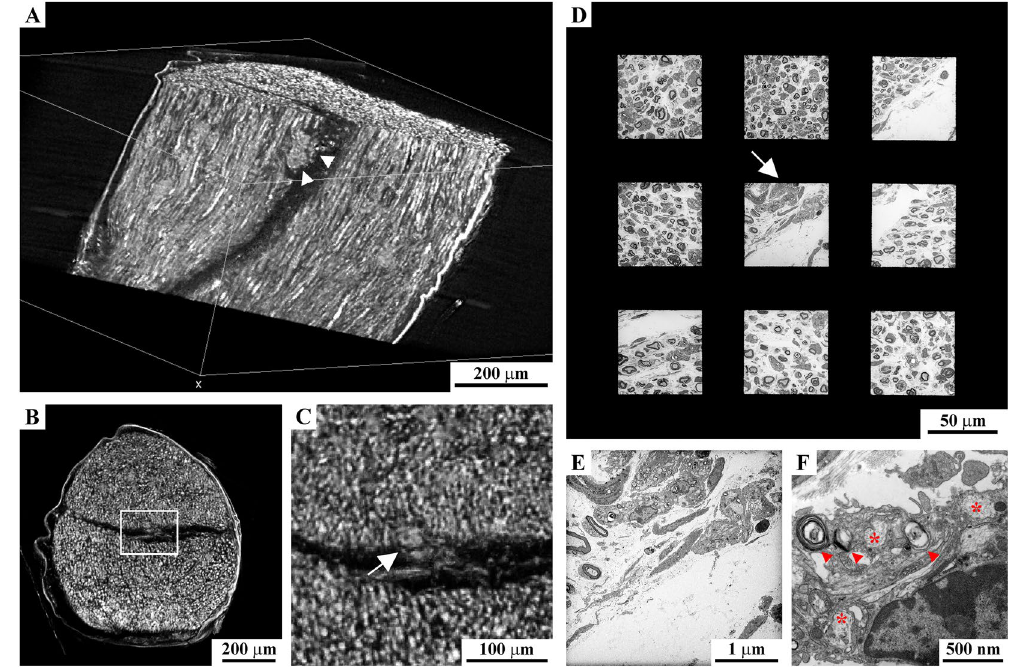
Figure 5. Identification of the same globoid cell in the sciatic nerve in 3D rendering, in virtual slices and in sections for TEM. ( A ) 3D rendering of a portion of sciatic nerve treated with the small-size protocol, in which it is possible to identify an infiltrating cell (white arrowheads). ( B ) Virtual slice of the same sample. ( C ) Higher magnification the boxed region, in which the selected cell is pointed out (arrow). ( D ) Identification of the same cell in 2D TEM map (arrow). ( E , F ) Ultrastructural characterization of the selected cell. Arrowheads and * highlight specific morphological characteristics of globoid